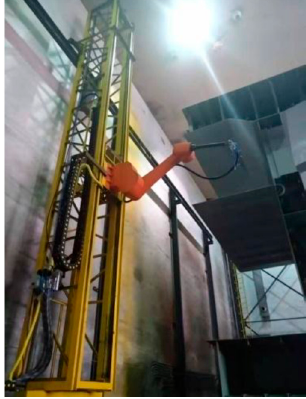
Figure 7. Painting operation by side suspension painting robot. Table 12. Distribution of dry film thickness.